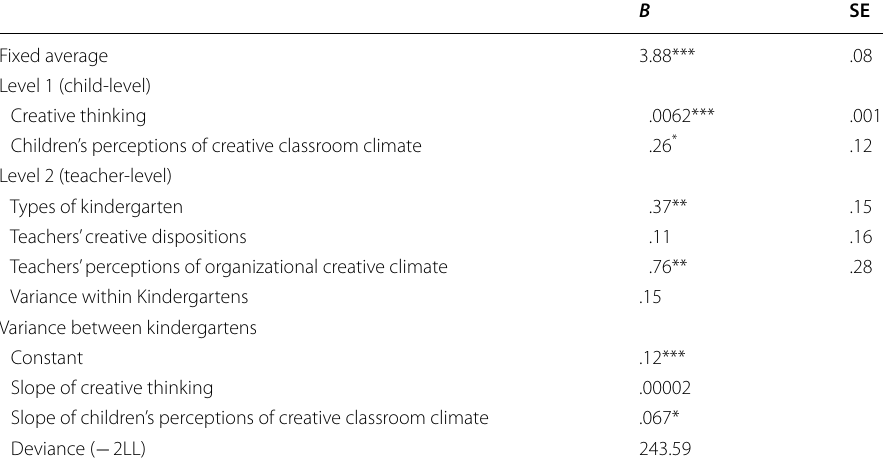
Table 5 The results of the conditional model children’s creative